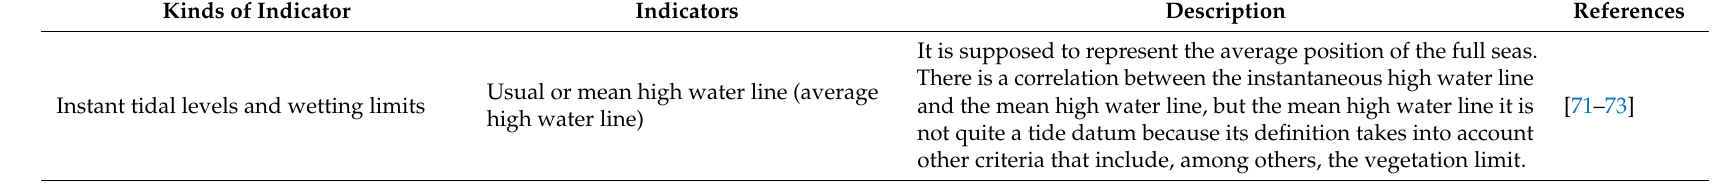
Table 4. Summary of shoreline indicators (adapted from [8,9]